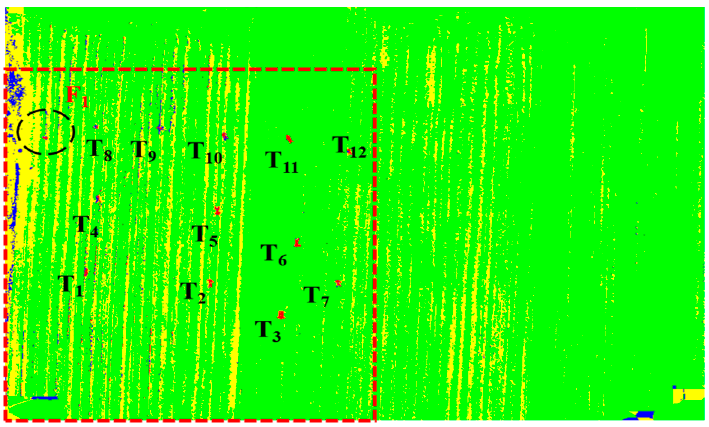
Figure 13. Suspected target recognition result in Scenario 1 ( green for vegetation, yellow for soil, red for suspected target, blue for noise spot ).